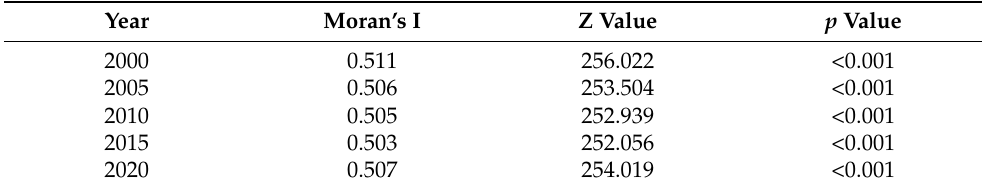
Table 5. The analysis of spatial autocorrelation in